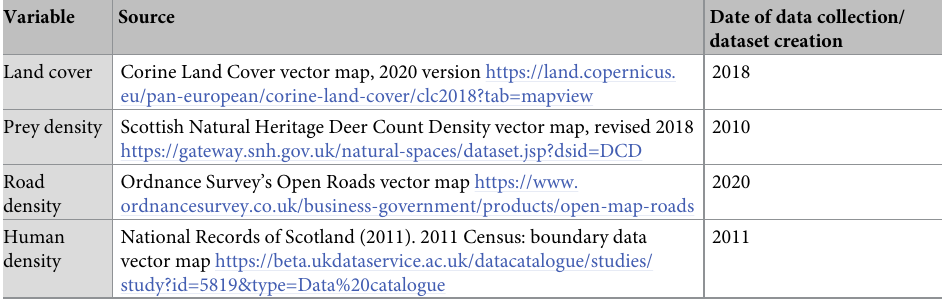
Table 1. Datasets and their sources used in the analysis of habitat